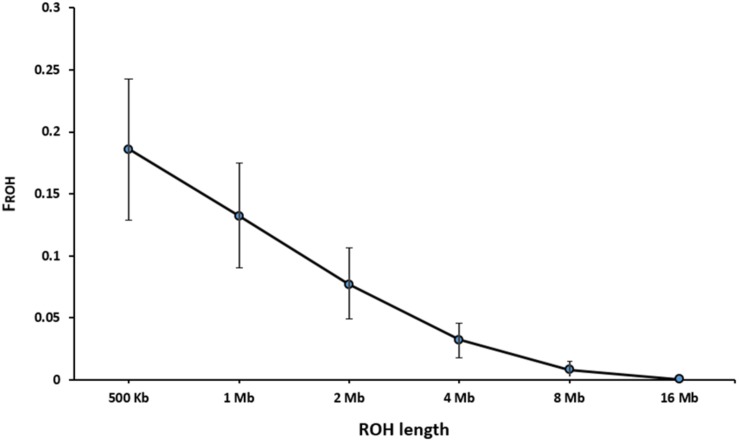
Trend of FROH based on the cut-off length categories for defining ROH.